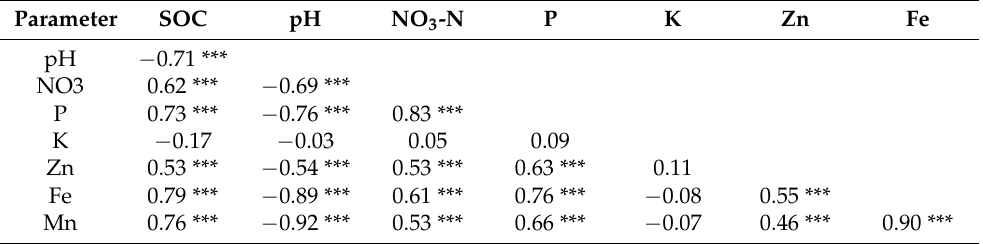
Table 5. Correlation coefficients of soil organic carbon (SOC), pH, nitrate, phosphorus (P), Potas- sium (K), iron (Fe), zinc (Zn) and manganese (Mn) concentrations measured three months after tillage